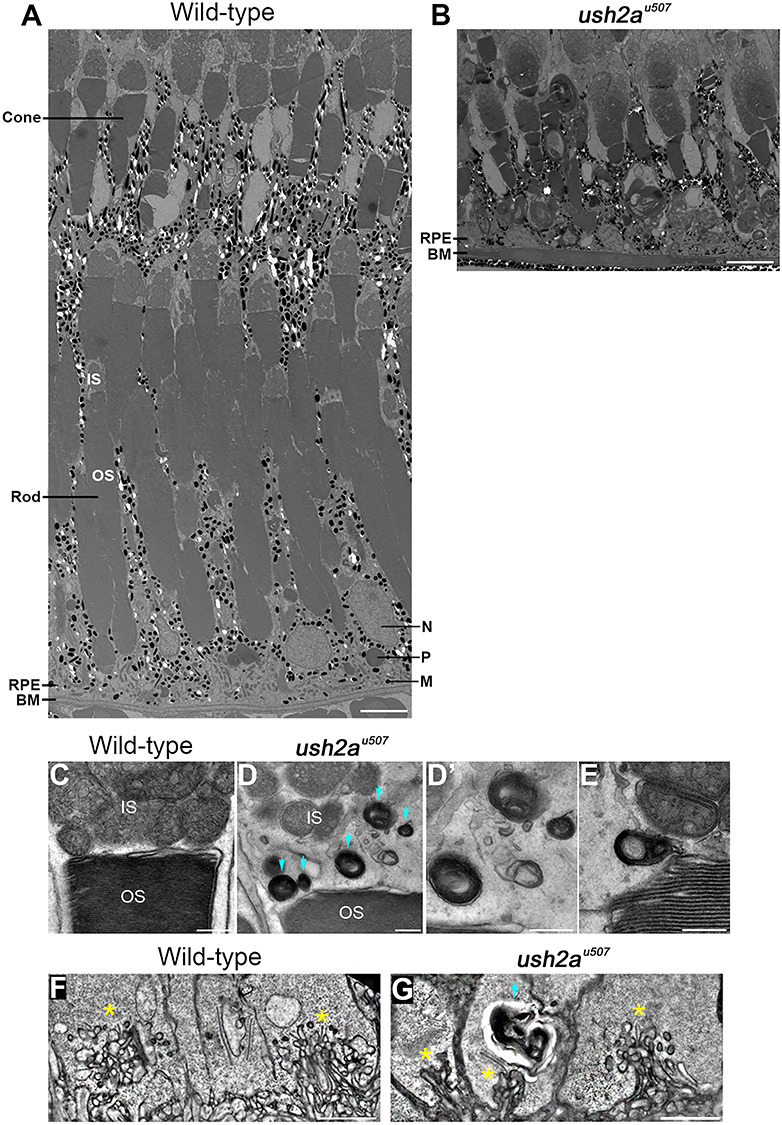
Retinal ultrastructure of ush2au507 zebrafish. Transmission electron microscopy was used to examine the wt and ush2au507 retinal ultrastructure at 6 months post fertilization (mpf). The wt retina showed tiers of morphologically distinct cone and rod photoreceptors with overlying retinal pigment epithelium (RPE) with long apical projections that interdigitated with the photoreceptors (A). Among mostly preserved tissue, regions of rod loss could be observed in the ush2au507 retina (B). Presumptive lysosomal structures (blue arrows) were noted at the inner and outer segment boundary (D, E) and at the synapses (G) of the ush2au507 photoreceptors at 6 mpf. Ribbon synapses are indicated by *. These vesicles were not observed in wt photoreceptors (C, F). IS, inner segment; OS, outer segment; IS, inner segment; OS, outer segment; RPE, retinal pigment epithelium; BM, Bruch’s membrane; N, nucleus; P, phagosome; M, melanosome. Scale bars = 5 μm (A, B, F, G) and 500 nm (C–E).